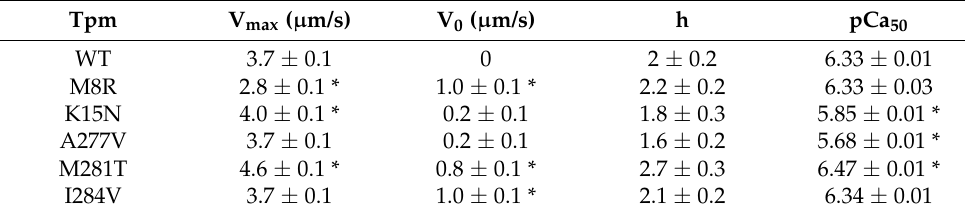
Figure 7. Tpm WT ( a ) and Tpm M8R mutant ( b ) affinities to F-actin in the presence of TnT1 fragment and Tn-complex (with EGTA). Results obtained by co-sedimentation assay. S—supernatants after centrifugation, P—pellets after centrifugation. Lanes 1–2: supernatants (1) and pellets (2) of actin sedimented with Tpm alone; lanes 3–4: supernatants (3) and pellets (4) of actin co-sedimented with Tpm and TnT1; and lanes 5–6: supernatants (5) and pellets (6) of actin co-sedimented with Tpm and whole human cardiac Tn complex. The Tpm1.1 M8R mutation is a homolog of the Tpm3.12 M9R mutation which causes nemaline myopathy [26,27]. It was shown previously that Tpm3.12 M9R is not able to regulate thin filament movement in the in vitro motility assay [28]. However, our in vitro motility assay data clearly showed that Tpm M8R, in contrast to Tpm3.12 M9R, demon- strates the Ca 2+ regulation of the actin–myosin interaction (Figure 6b). To clarify this